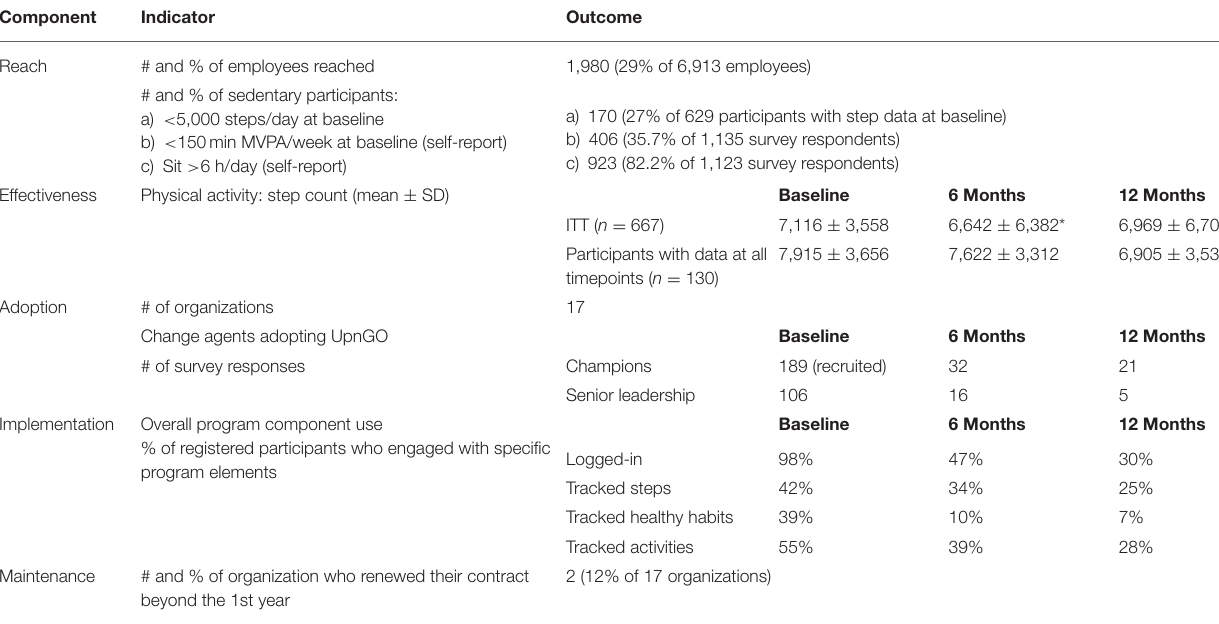
TABLE 2 | RE-AIM framework evaluation. Component Indicator Outcome Reach 1,980 (29% of 6,913